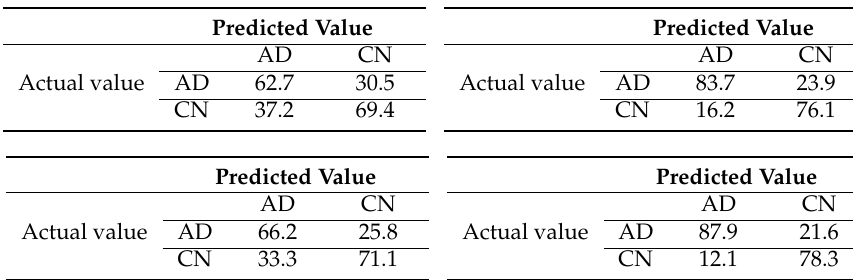
Table 5. Average confusion matrix for the validation tests, showing the classification rate in percentage for the dataset of subjects aged 60 and over ( upper table ) and for the reduced dataset ( lower table ). Tables on the left correspond to the Clinica baseline, tables on the right correspond to the proposed method (linear